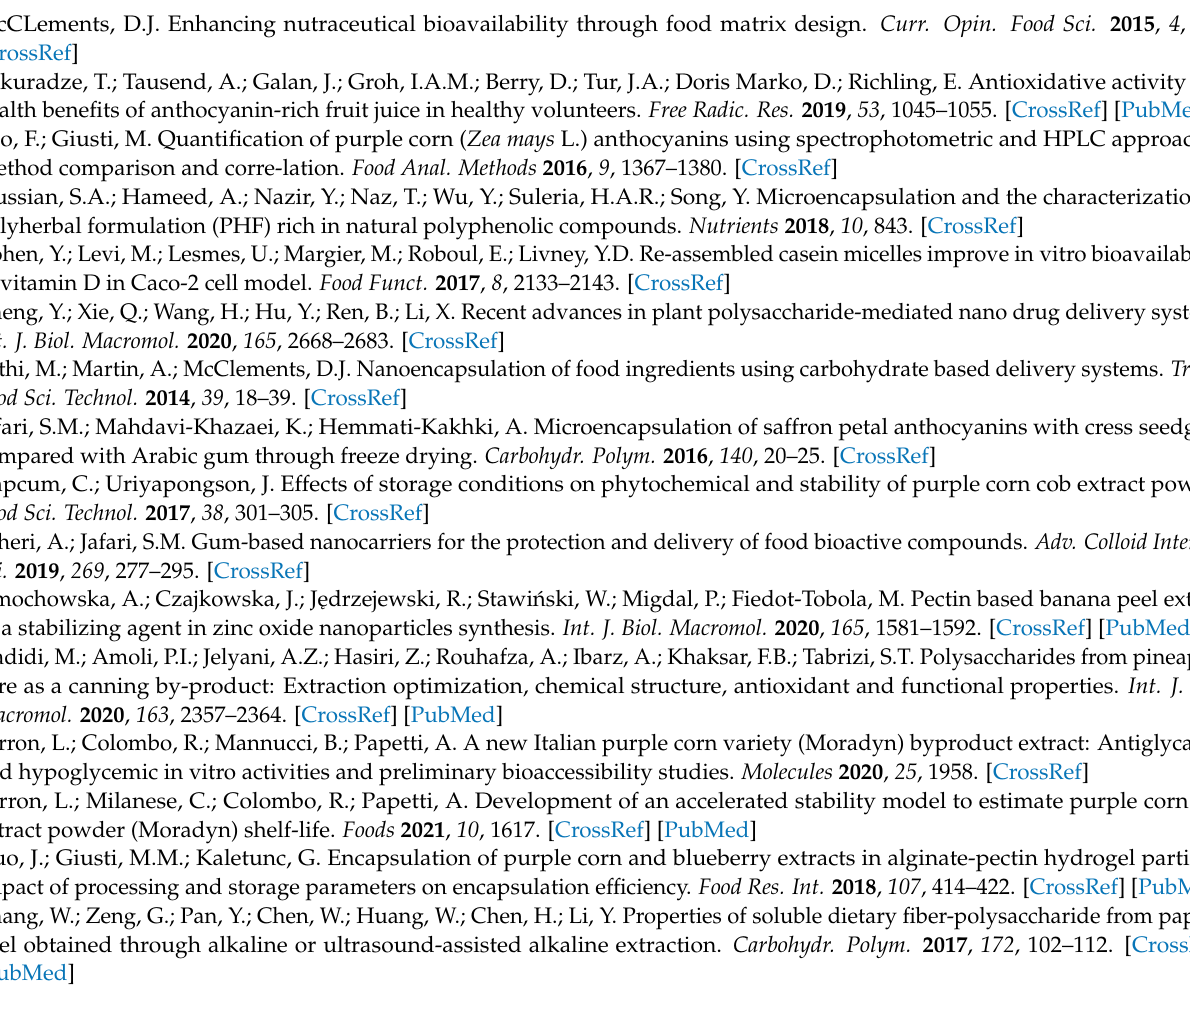
(red line) going from the origin to the point corresponding to the specification limit of degradation; Table S1: Coded levels and real values for EMCP extraction process and yield results. Runs were reported following their standard order; Table S2: Coded levels and real values for CCP extraction process and yield results. Runs were reported following their standard order; Table S3: Coded levels and real values for CBP extraction process and yields results. Runs were reported following their standard